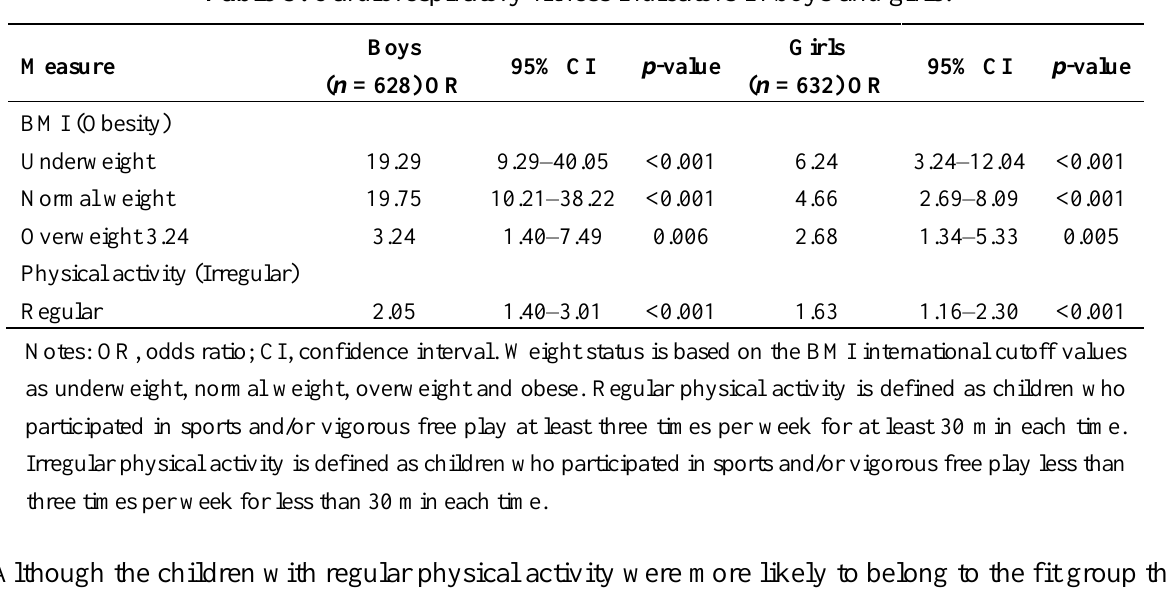
Table 3. Cardiorespiratory fitness indicators in boys and